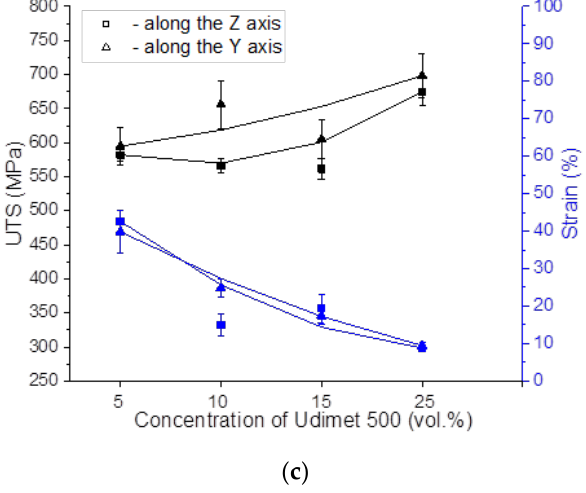
Figure 13. Stress–strain diagrams ( a,b ) and concentration dependencies of ultimate tensile stress and strain-to-fracture ( c ) for the composites.